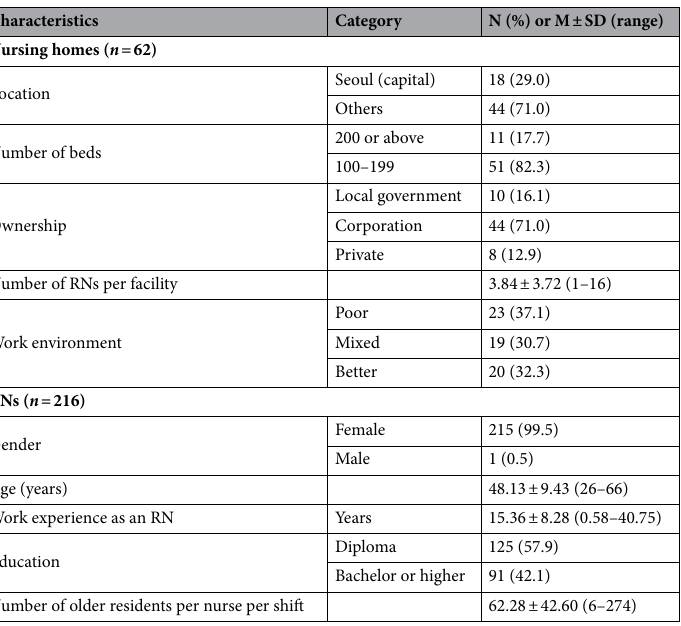
Table 1. Characteristics of nursing homes (N = 62) and RNs (N = 216). RNs Registered